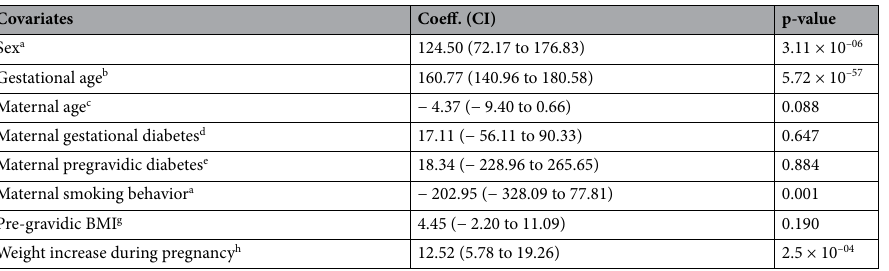
Table 2. Results of the association analysis between clinical and anthropometric variables and birthweight. a This information was available for 1037 subjects. b This information was available for 1046 subjects. c This information was available for 1029 subjects. d This information was available for 1043 subjects. e This information was available for 1041 subjects. f This information was available for 733 subjects. g This information was available for 731 subjects. h This information was available for 726 subjects.